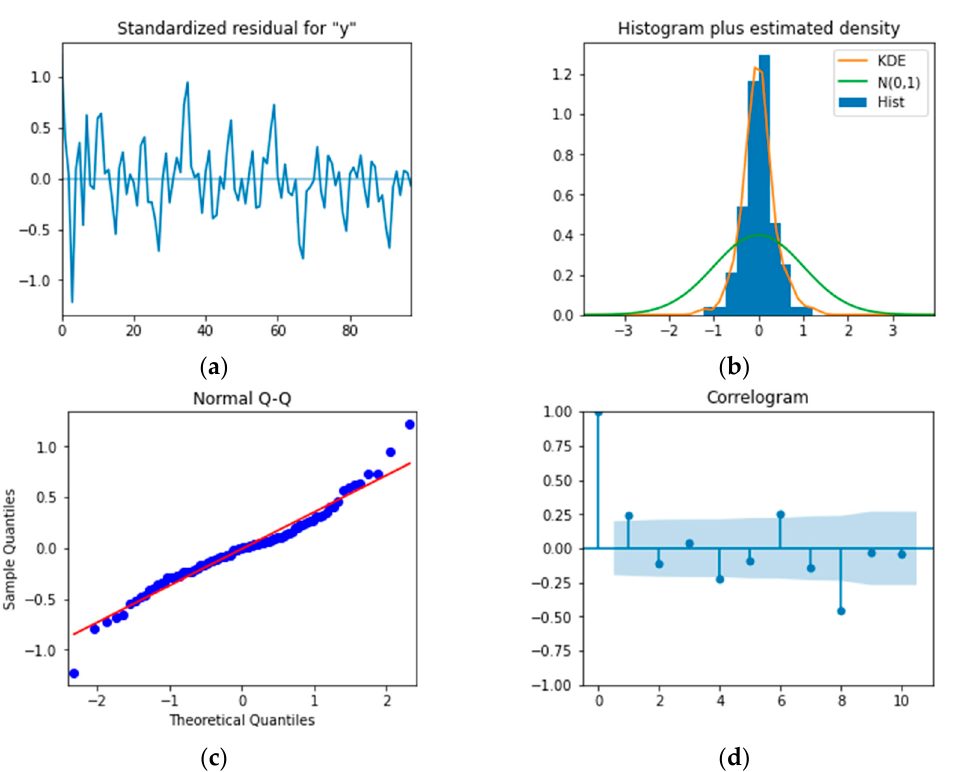
Figure 10. Model checking plots: ( a ) Timing graph of the residual; ( b ) Distribution plot of the residual; ( c ) Q-Q plot of the residual; ( d ) ACF of the residual.